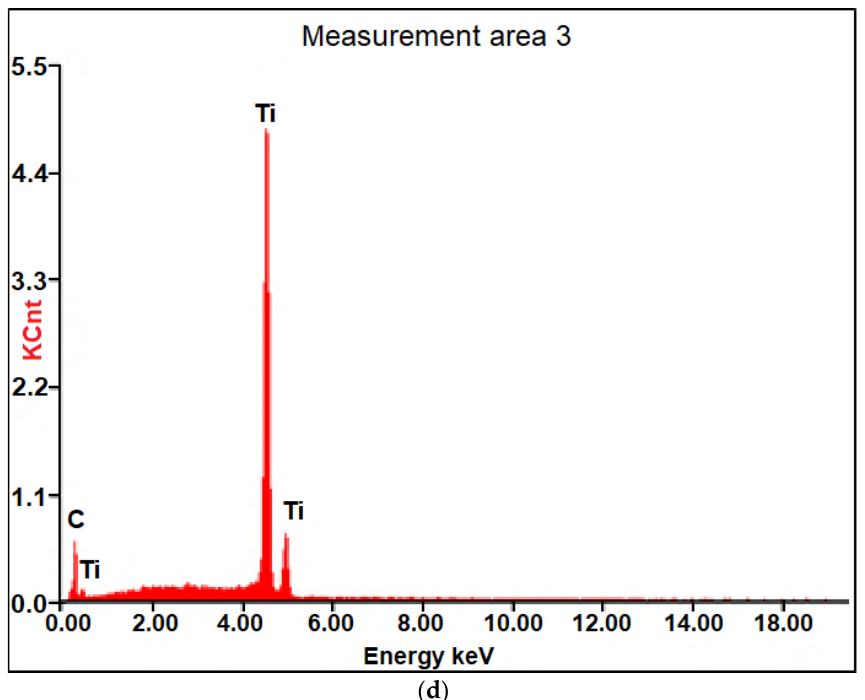
Figure 3. Results of the microanalysis of the chemical composition of the Co3+TiC+PD-W composite powder: ( a ) SEM image of the morphology of the powder particles with the area subjected to analysis and the diagrams of scattered X-radiation with energy lines present in the area of components (chemical elements) subjected to analysis: ( b ) matrix, ( c ) ceramic particle (TiC) and ( d ) tungsten-coated synthetic metal–diamond composite (PD-W).